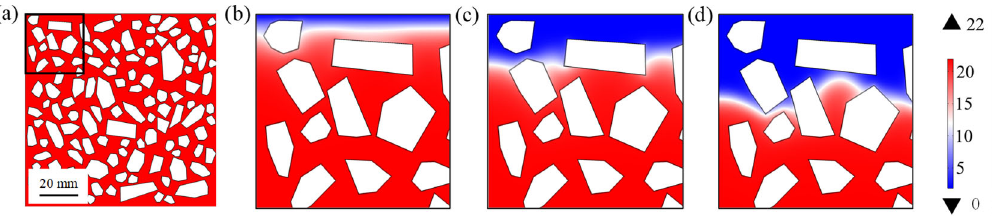
Figure 12. Distributions of calcium ion concentration in concrete pore solution on different ingress time. ( a ) Before sulfate attack, ( b ) 60th day, ( c ) 180th day, and ( d ) 360th day of sulfate attack, respectively.